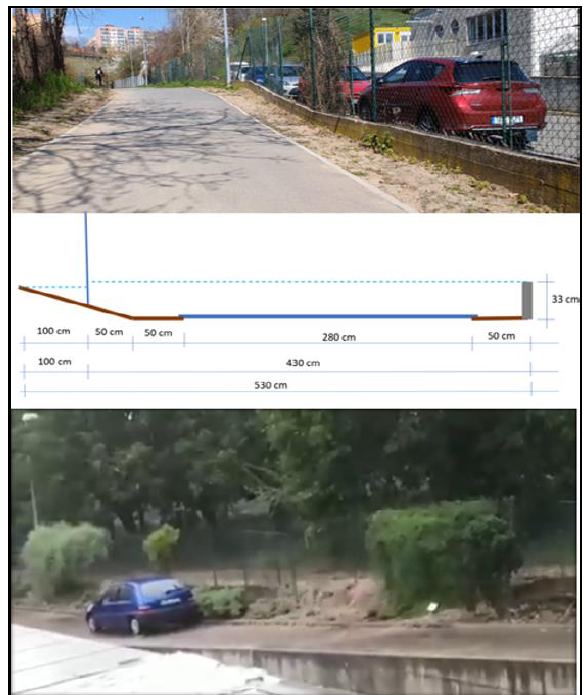
Figure 8 Calibration site “Jiri Janda” for rainfall event from 14.8.2020 – during dry weather (top) and cloudburst (bottom) The model calibration was performed at the location downstream of a problematic drop manhole causing the spill of water on the surface. The street (“Jiri Janda”) got completely flooded (Figure 8) from the drainage network with an estimated maximum flow between 6 and 7 m 3 /s and maximum height above 33 cm. These parameters were used to calibrate model performance under these extreme rainfall conditions. The model was verified on the flood extent data provided by Prague ZOO. As Prague ZOO is located downstream of the problematic drop manhole and water outflow from the drainage network. The ZOO was hit by a flood wave what allowed to carefully document the flood from 14 August.2020 for insurance purposes. The ZOO flood map was then therefore used to verify the surface flood results provided by the simulation model (Figure 9). In parallel, several other locations were photo-documented or recorded by local inhabitants. This information helped to perform the final model